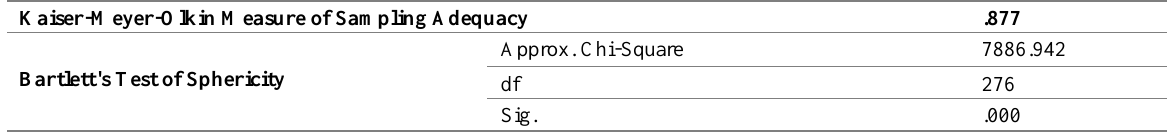
Table 6: Kaiser-Meyer-Olkin of the Corporate Social Responsibility